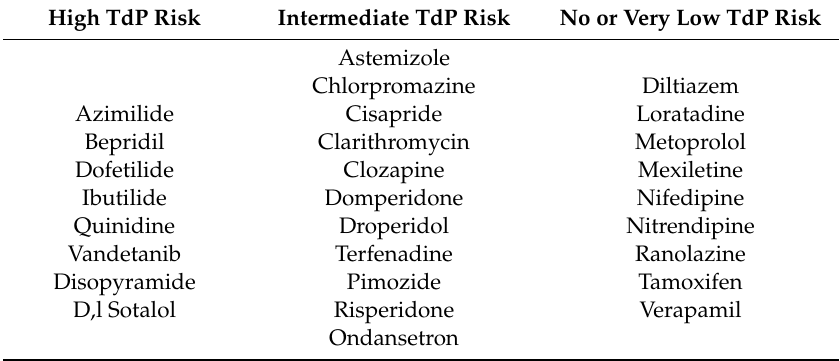
Table 2. List of CiPA compounds defined by CiPA initiative * (May 2016)